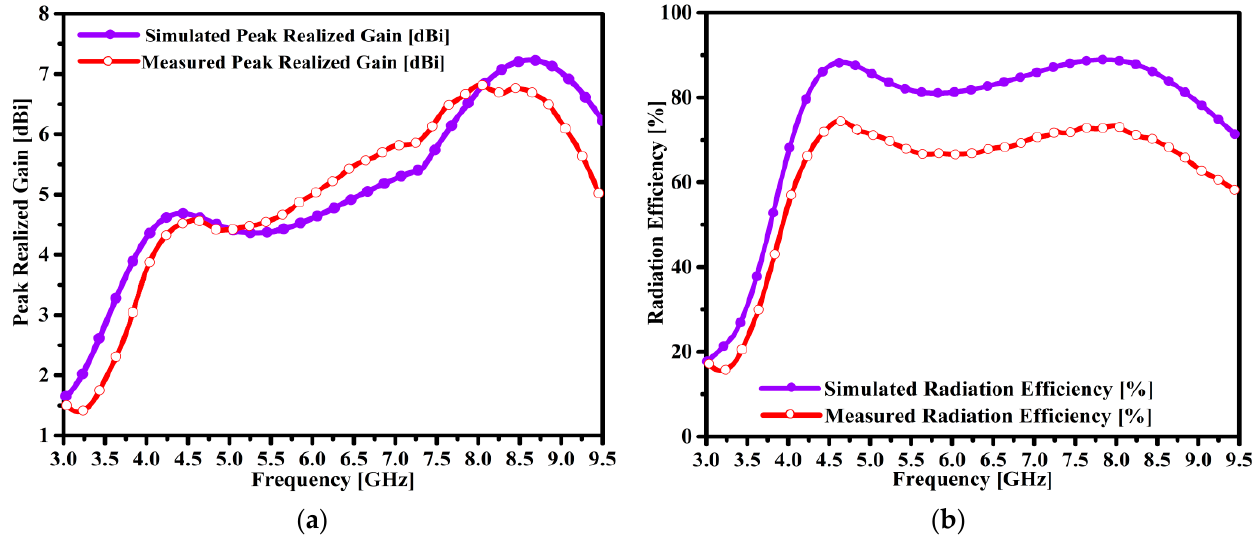
Figure 8. Comparing the simulation and measurement results of the antenna, ( a ) the peak realized gain, and ( b ) the radiation